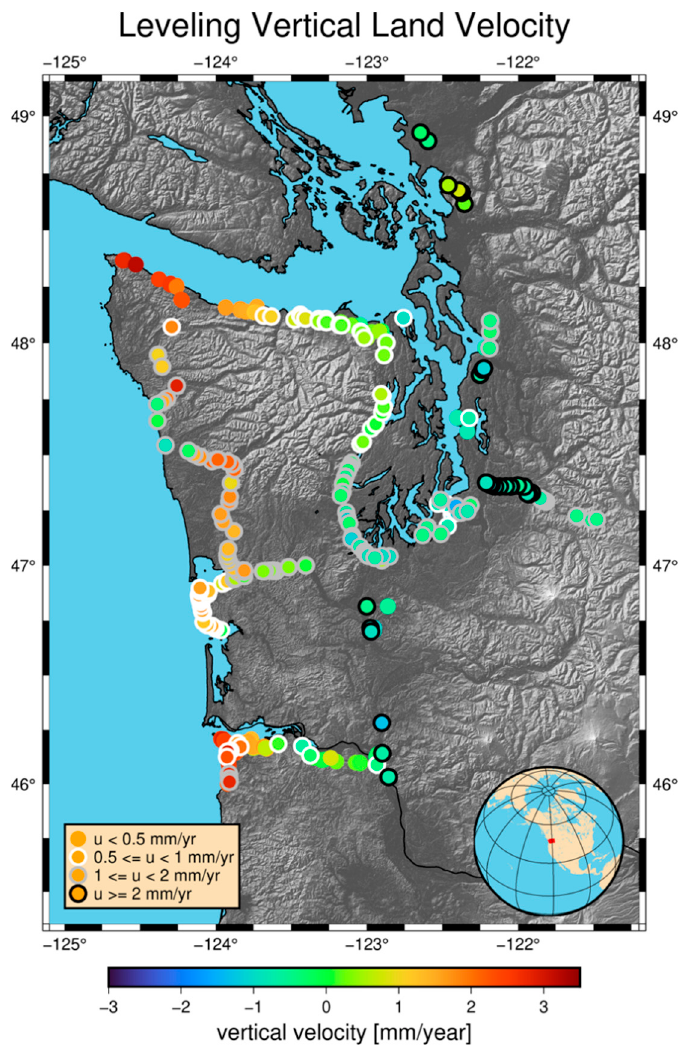
Figure 3. Measurements of vertical land movement derived from leveling. Vertical velocity is denoted by marker color and uncertainty is denoted by marker outline, expressed as millimeters per year (mm/yr). Spatially dense leveling observations perpendicular to the Cascadia subduction zone show the dominant east-west VLM signal resulting from interseismic locking on the megathrust. Refer to Figure 2 for place names. North is up.